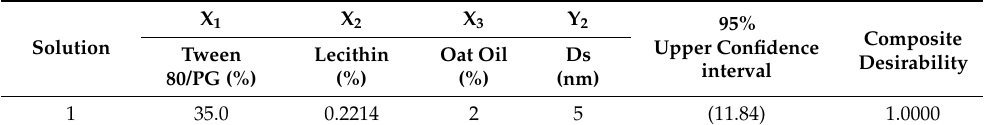
Table 11. Response optimization for mean droplet size (Ds) by minimizing the response and keeping X 3 at maximum level.